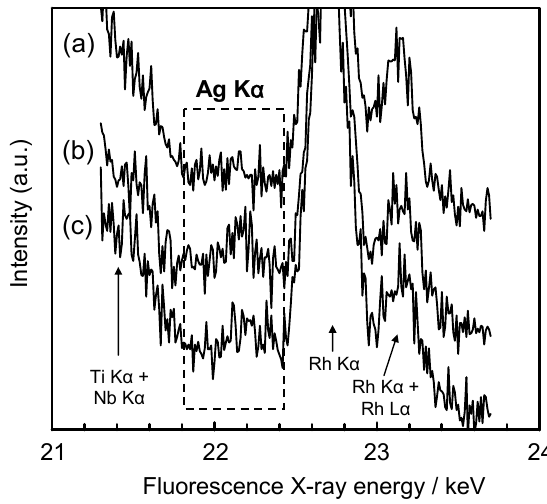
Table 2. Concentrations of the detected elements by XRF on TNTZ specimen surfaces with/without MAO treatments.